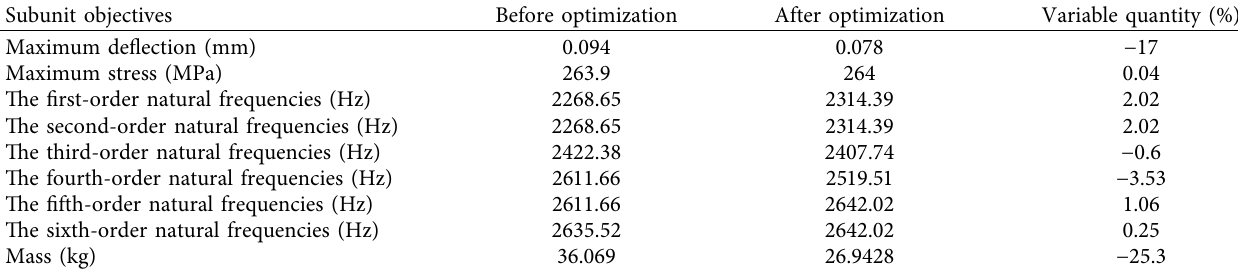
Table 4: Comparison of gear performance before and after multiobjective optimization. Subunit